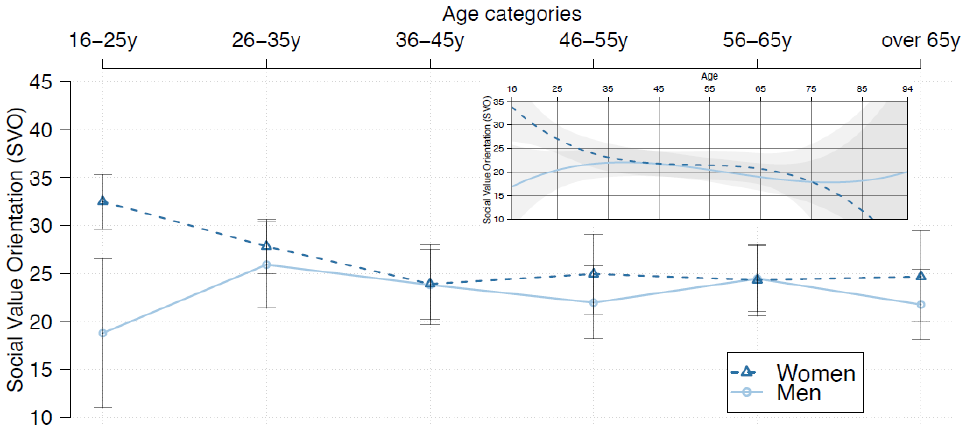
Figure 1. Average Social Value Orientation (SVO) of men and women in different age groups. Larger SVO values indicate more altruistic-prosocial preferences. Insert shows the predicted SVO by age for men and women from a multivariate polynomial regression with cubic splines and further control variables (see Table A3 in the Appendix B). Grey bars and shading show 95% CIs.